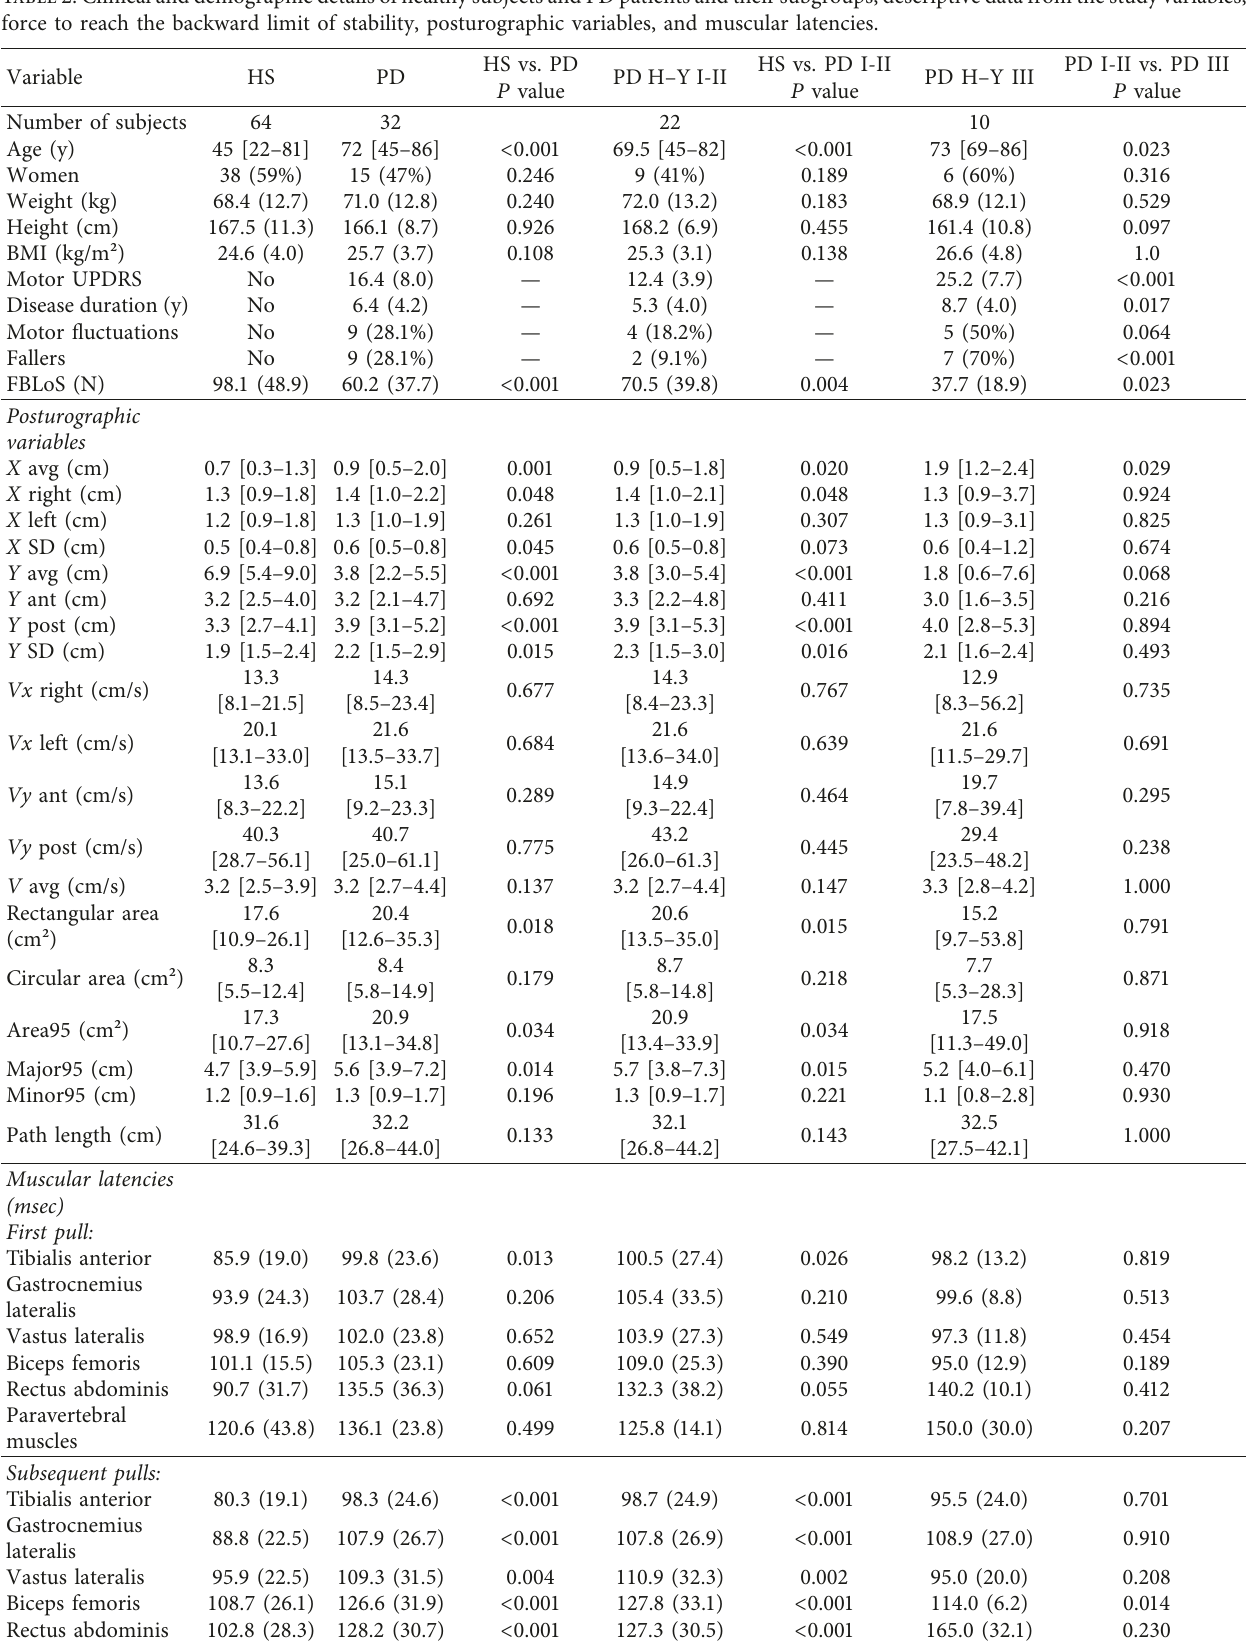
Table 2: Clinical and demographic details of healthy subjects and PD patients and their subgroups, descriptive data from the study variables, force to reach the backward limit of stability, posturographic variables, and muscular